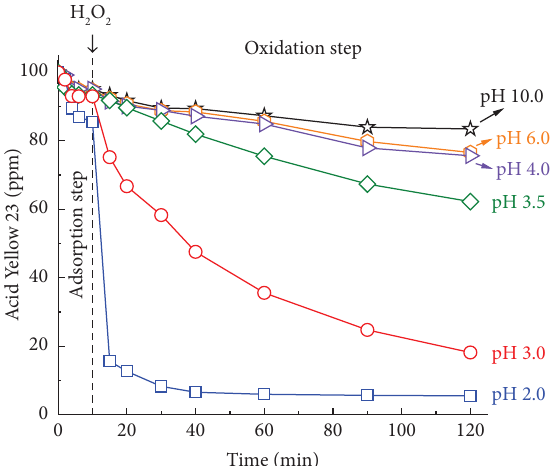
Figure 14: Efect of pH on AY23 decolorization using MPC catalyst (0.80 g/L MPC-R0.1–2.0h, 200ppm H